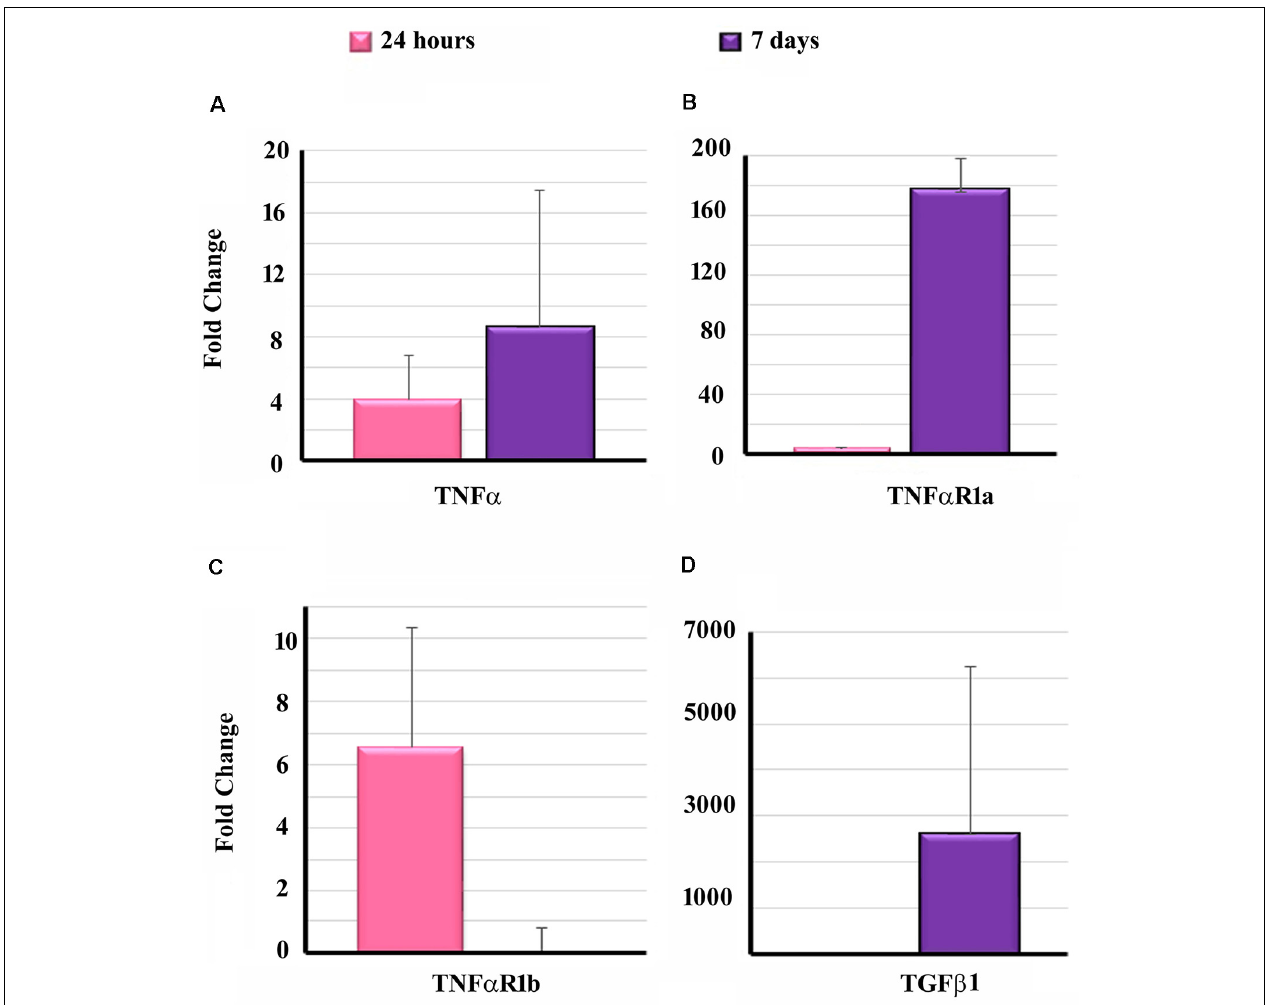
FIGURE 5 | Expression of pro-inflammatory and pro-fibrogenic genes in the cochleae of implanted animals. Cochleae from guinea pigs implanted with non-drug eluting electrodes were harvested at the different post-EIT time period and subjected to real-time PCR to determine the levels of TNF- α (A) , TNF α R1a (B) , TNF α R1b (C) and TGF β 1 (D) . Data are expressed as fold change compared to the control group and represents mean ± standard